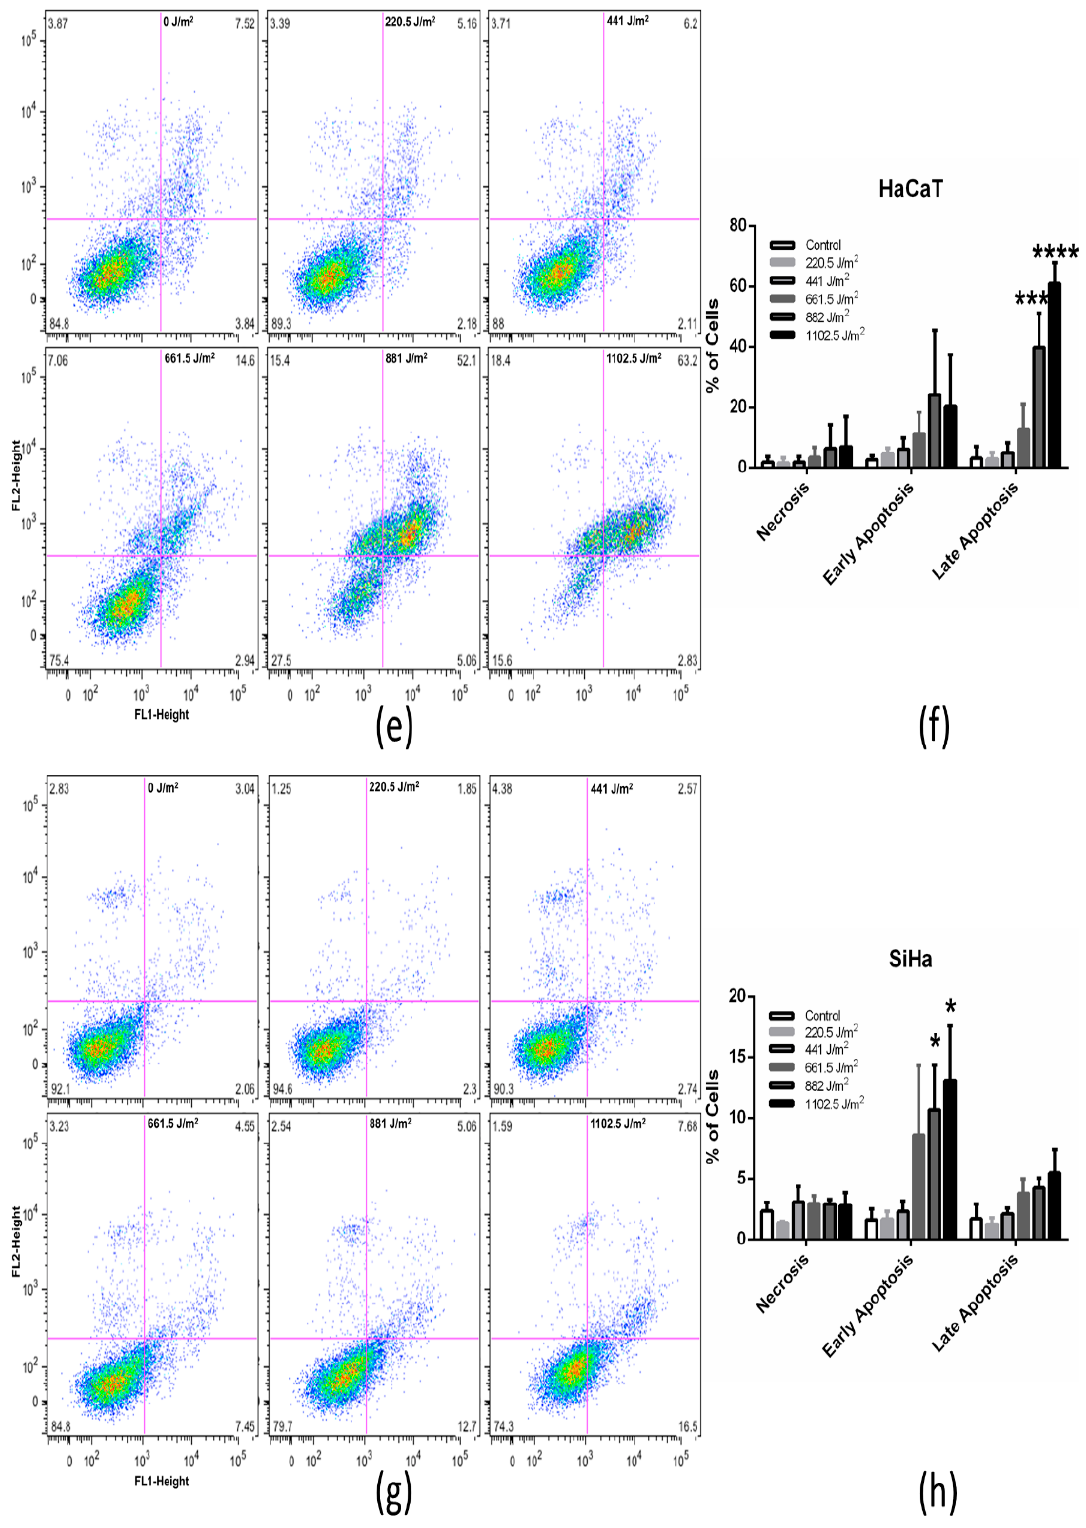
Figure 3. UVB differentially inhibits cell death of immortal and tumorigenic cell lines. Apoptosis and necrosis were analyzed by flow cytometry after 72 h of incubation in ( a ) C-33A, ( c ) CaLo, ( e ) HaCaT and ( g ) SiHa cells treated with increasing doses of UVB. The quantity of ( b ) C-33A, ( d ) CaLo, ( f ) HaCaT and ( h ) SiHa cells in early apoptosis, late apoptosis and necrosis are graphed. Cells in lower left quadrant are negative for Annexin-V and IP. Cells in upper left quadrant are necrotic cells.